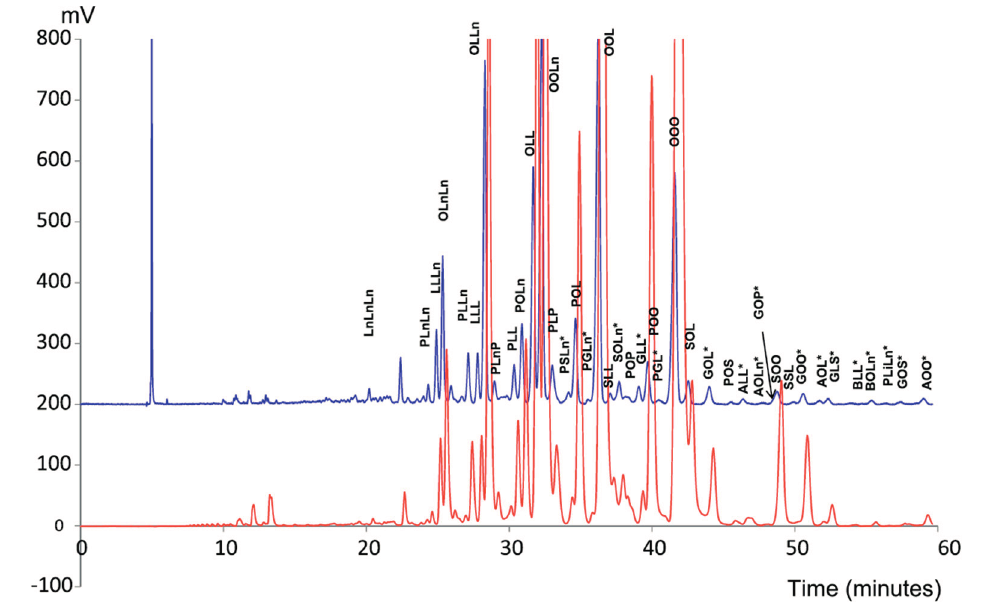
Figure 5. UV (blue) and ELSD (red) chromatograms for rapeseed oil with the optimal selected chromatographic system (60 cm Kinetex C18 + 15 cm Accucore C18) [30]. C16:0 (P, palmitic), C18:0 (S, stearic), C18:1 (O, oleic), C18:2 (L, linoleic), and C18:3 (Ln,